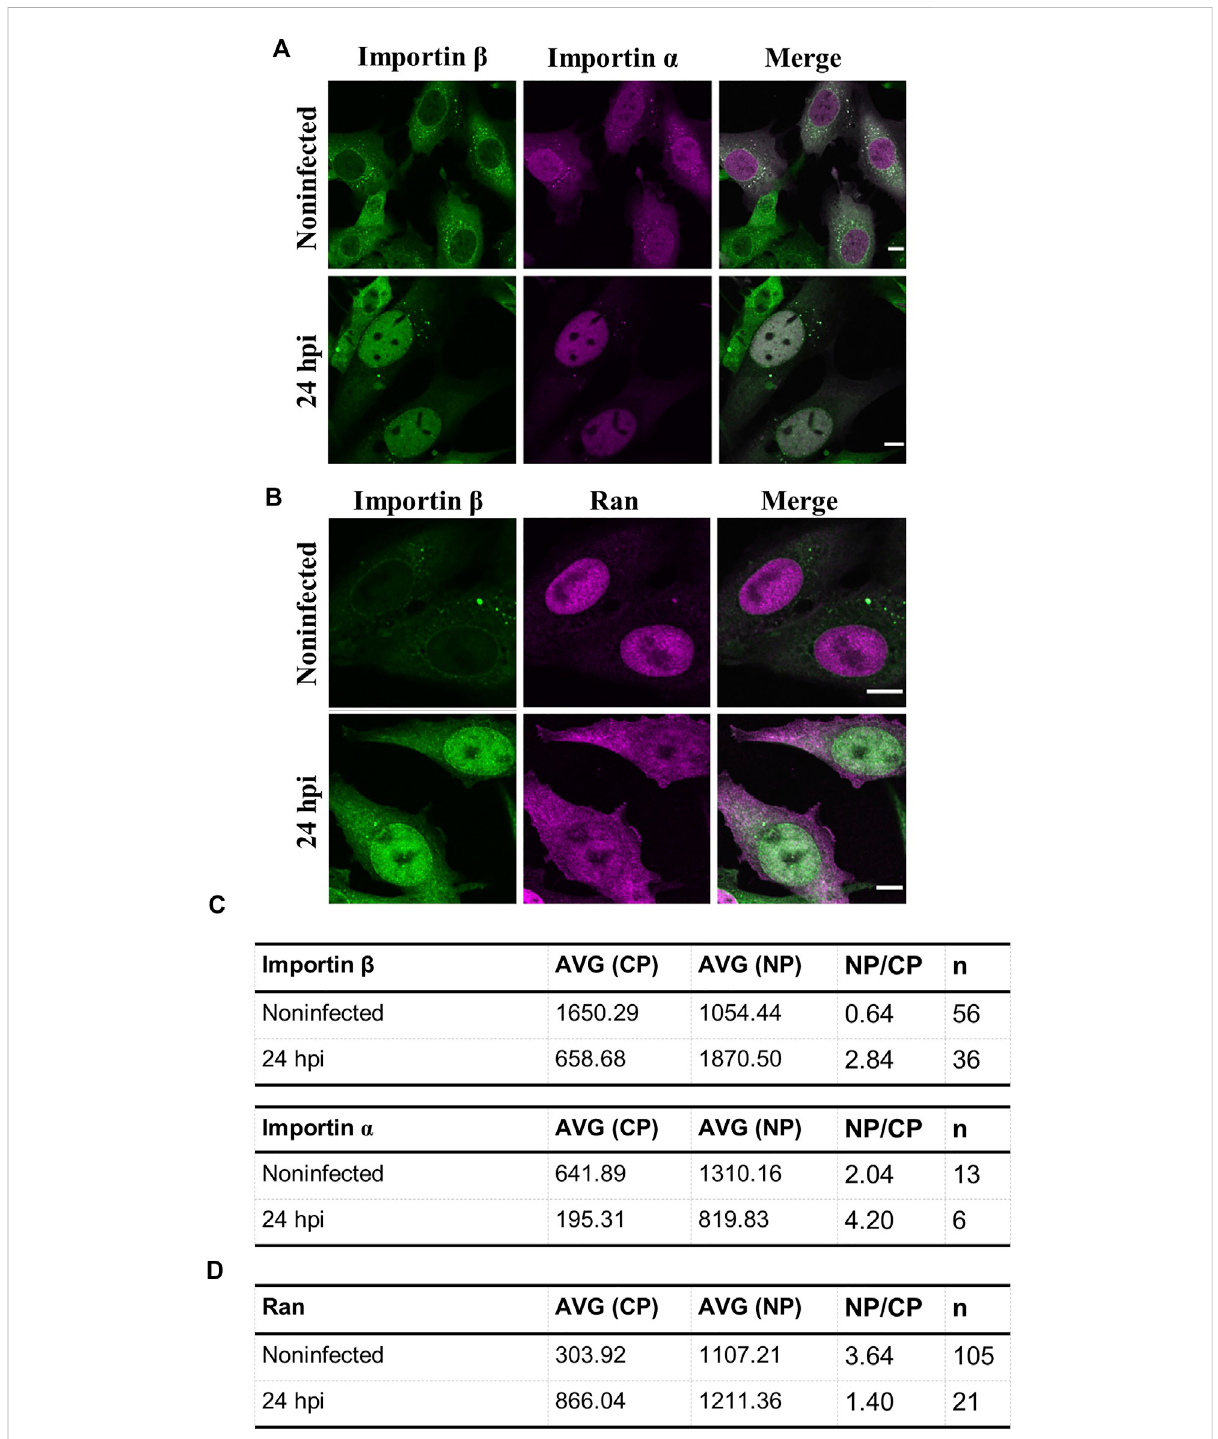
FIGURE 7 Intracellular distributions of importins and ran are changed in infected samples. Representative confocal images of intracellular distribution of (A) importin β together with either importin α or (B) Ran in non-infected and infected NLFK cells at 24 hpi. The cells were immunolabeled with antibodies against importin β (green) and ran (magenta). Importin a was expressed as fl uorescent importin α -EGFP (magenta). Scale bars, 10 µm (C) Quantitative analysis showing the nucleus-to-cytoplasmic ratio of importin β , α , and (D) Ran in non-infected and infected cells. Nucleus-to- cytoplasmicratioswerecalculated from averaged intensities of nucleartransportfactors inthenucleus and thecytoplasm. Nucleus-to-cytoplasmic ratiochangesofallthestudiednucleartransportfactorswerestatisticallysigni fi cant p < 0.05,andstatisticalanalysiswasperformedbyusingStudent´ s t